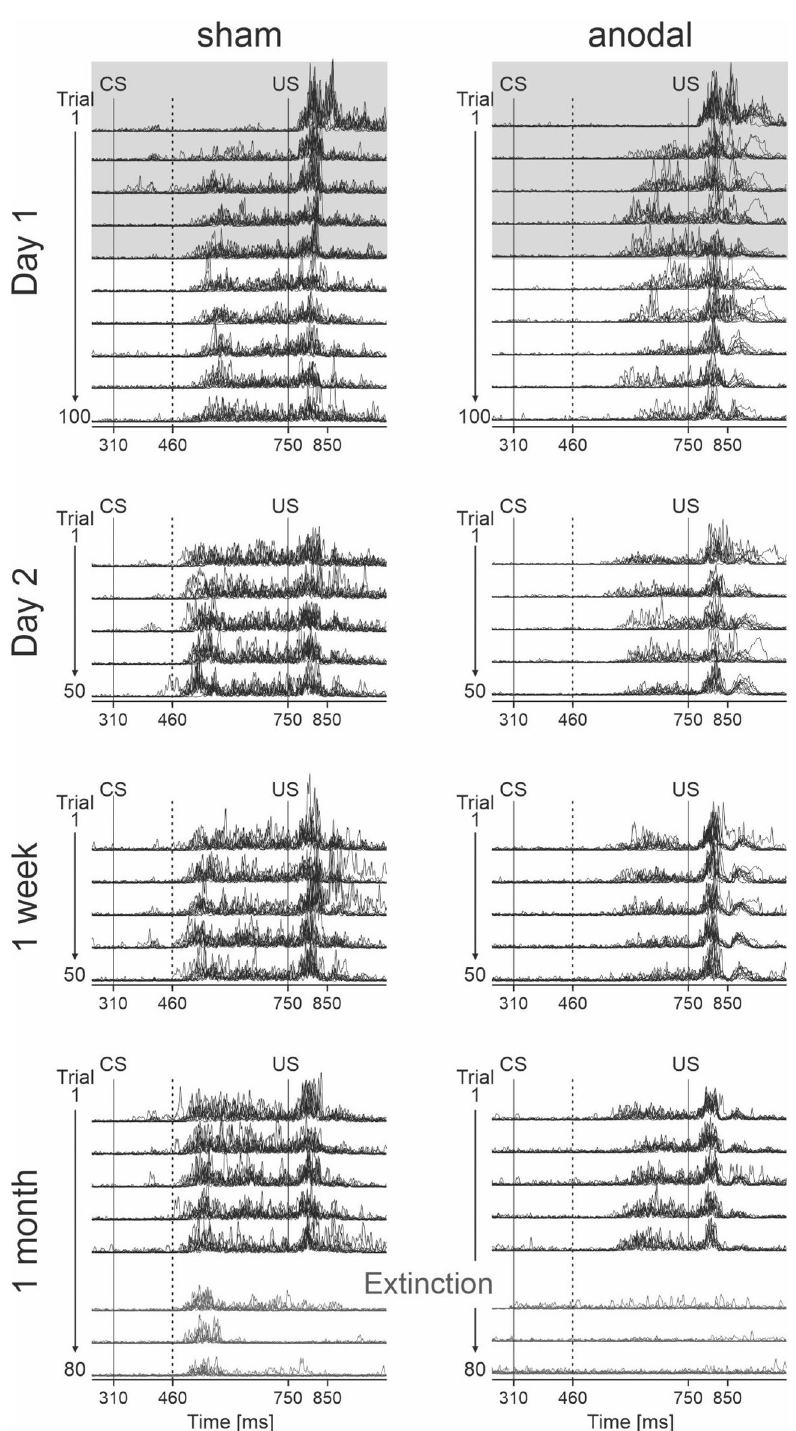
Figure 1. Individual examples of representative eyeblink recordings following sham and anodal tDCS across the four recording days. Rectified and filtered EMG-data of the orbicularis oculi muscle are shown. EMG recordings of 10 consecutive trials are superimposed. Day 1 is shown on the top, day 29 (1 month after stimulation) on the bottom. Duration of tDCS on day 1 is shaded in gray. Paired CS–US trials are shown in black, extinction trials are shown in green. The solid vertical lines indicate the onset of the CS and US, respectively. Responses occurring within the 150 ms interval after CS onset (dotted line) were considered alpha- responses. See “Methods” for further